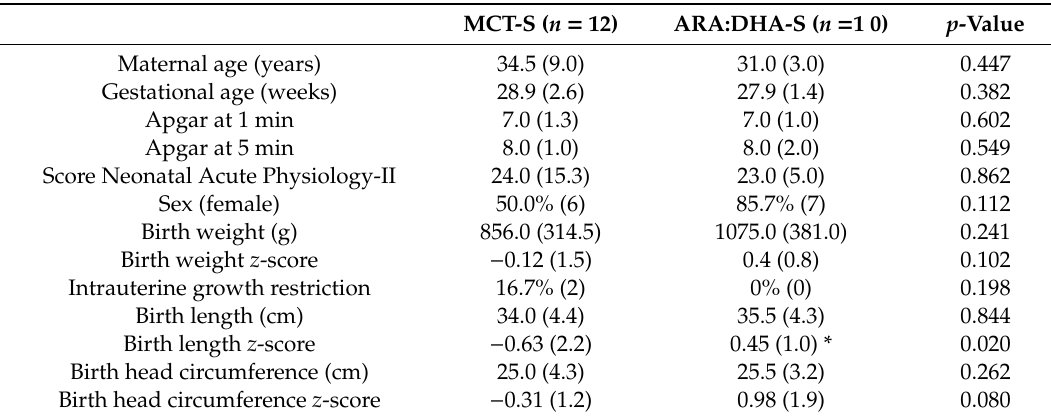
Table 2. Cohort baseline